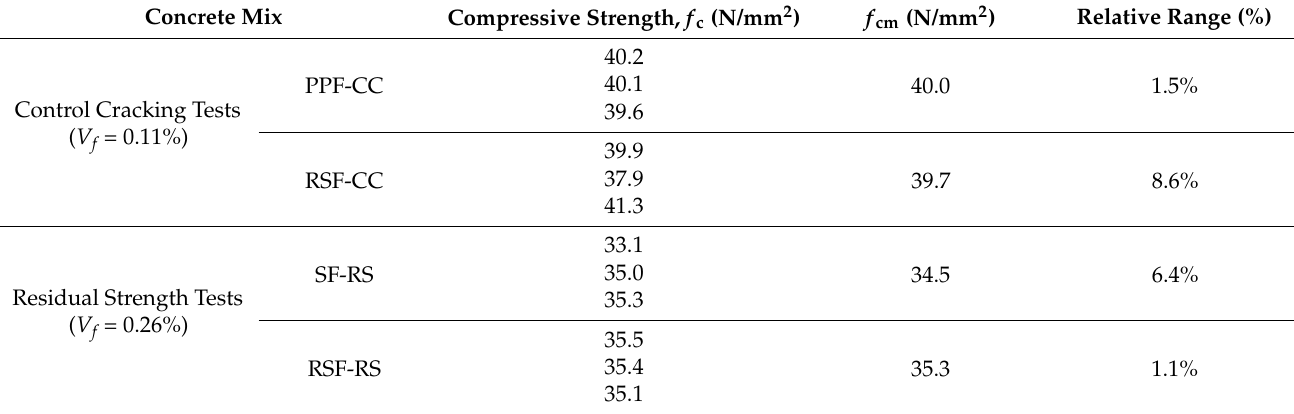
Table 4. Compressive strength